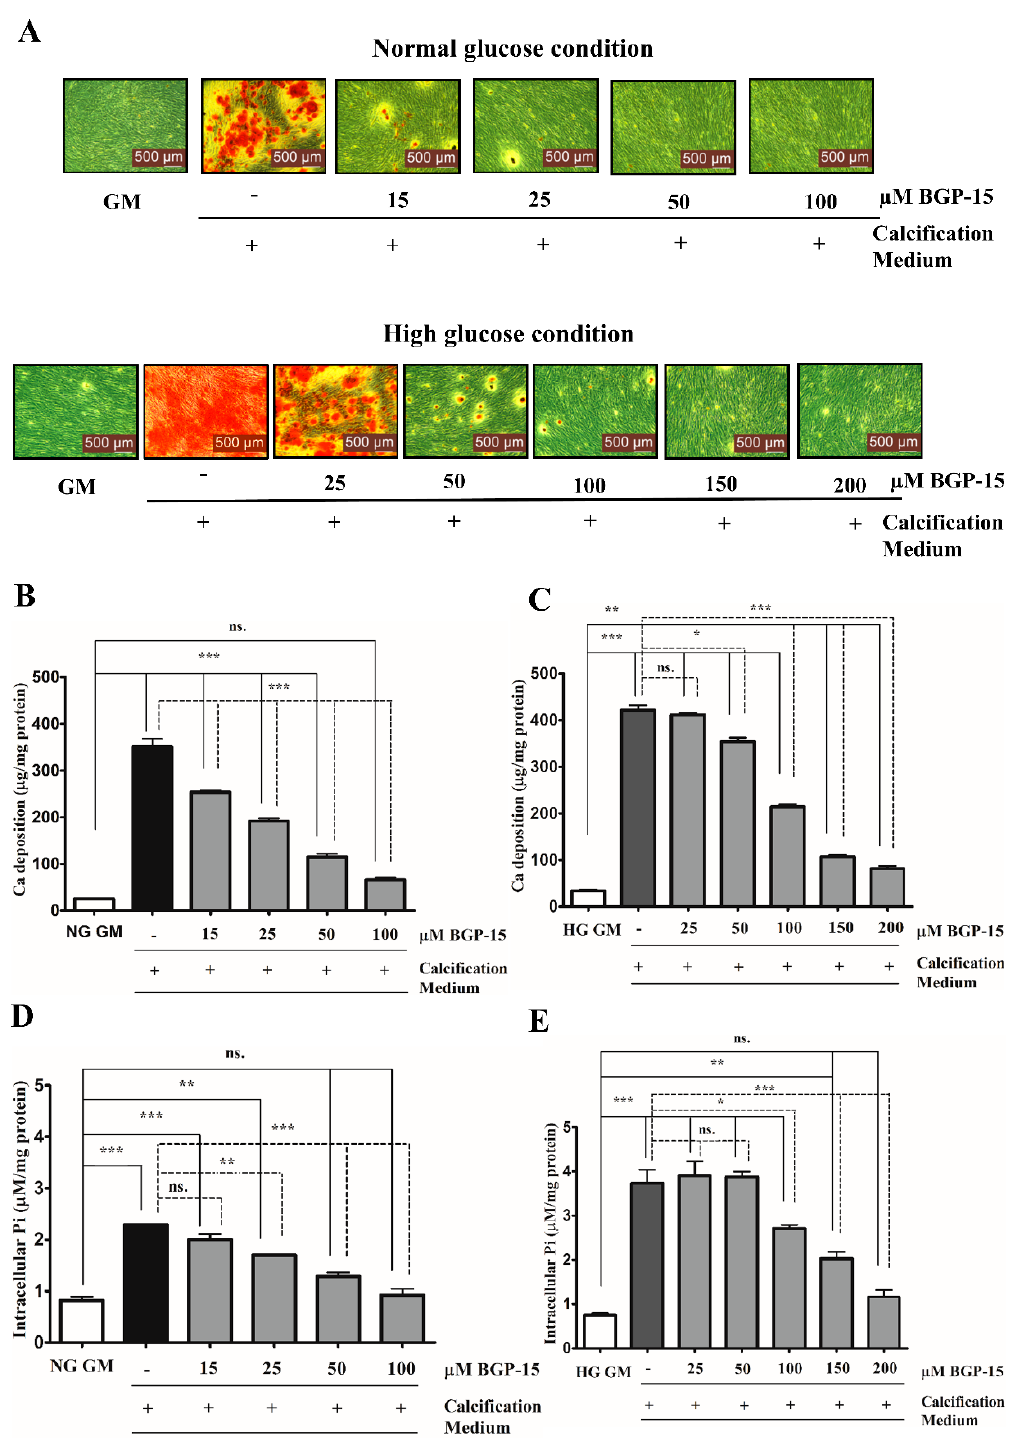
Figure 2. BGP-15 mitigates high Pi-induced ECM calcium deposition and Pi uptake of VSMCs in NG and HG conditions. VSMCs were cultured in calcification medium containing 3 mmol/L inorganic Pi under normal glucose (5.5 mM glucose; NG) and high glucose (11 mM; HG) conditions in the presence or absence of BGP-15 (15–100 µM BGP-15 in NG and 25–200 µM in HG condition) for 10 days. ( A ) Representative Alizarin Red staining is shown from three independent experiments. ( B ) Calcium content of solubilized ECM in NG and ( C ) HG conditions is presented. Data are expressed as mean ± SEM of three independent experiments. ( D ) Intracellular Pi levels in NG and ( E ) HG conditions are presented as mean ± SEM of three independent experiments. Statistical analysis was performed by the one-way ANOVA test followed by Bonferroni correction. A value of p < 0.05 was considered significant. ns: Non-significant; * p < 0.05, ** p < 0.01, *** p < 0.001.